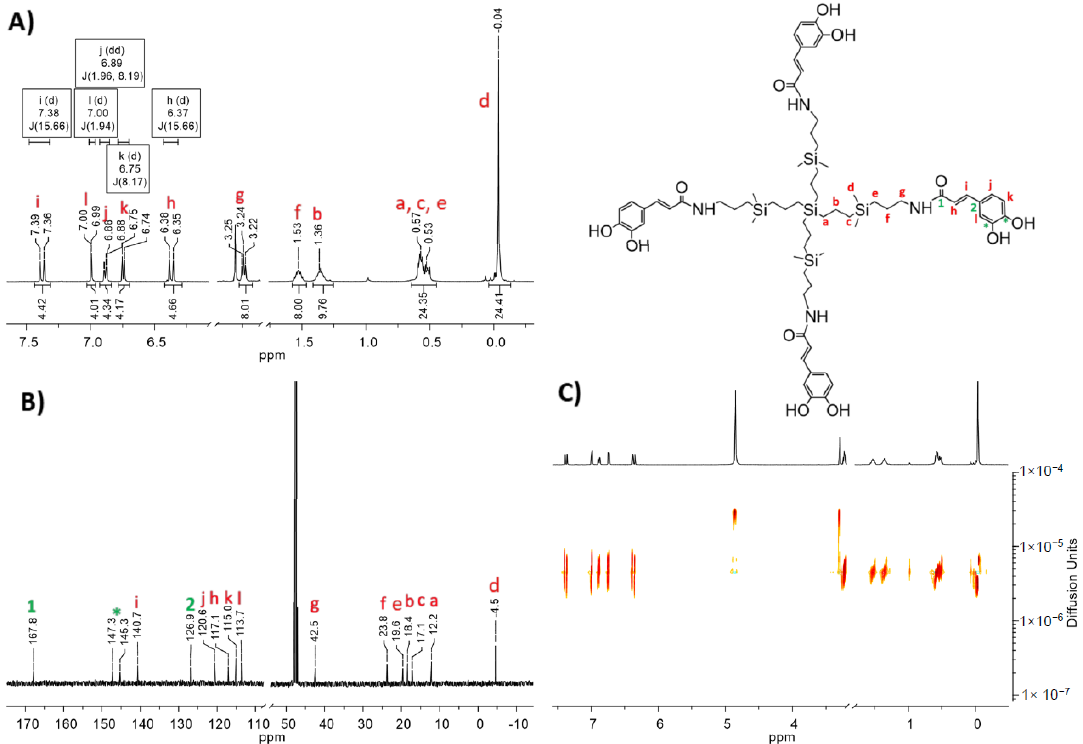
Figure 2. NMR spectra in CD 3 OD of compound G 1 -[Si(CH 2 ) 3 NH(CO)CH=CHCH 2 Ph(OH) 2 )] 4 ( 2 ): ( A ) 1 H-NMR, ( B ) 13 C-NMR, and ( C ) 1 H-DOSY-2D-NMR (d, doublet; dd, doublet of doublets).